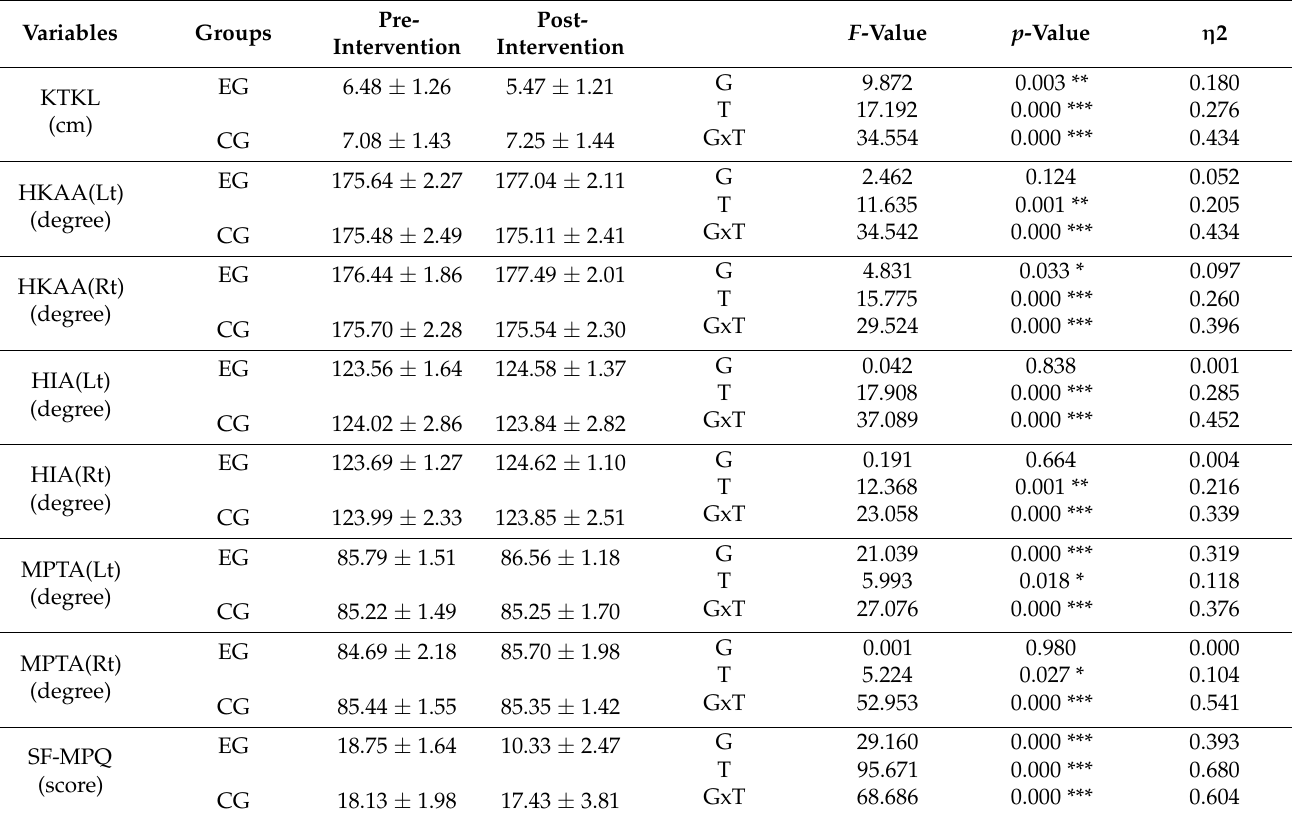
Table 3. Changes in structural variables and pain in patients with genu varum.